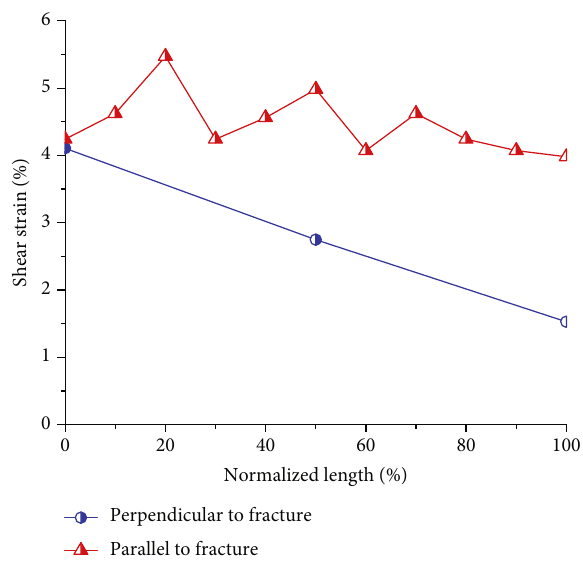
Figure 11: Shear strain gradient neighboring the C-T fracture. Table 4: Test